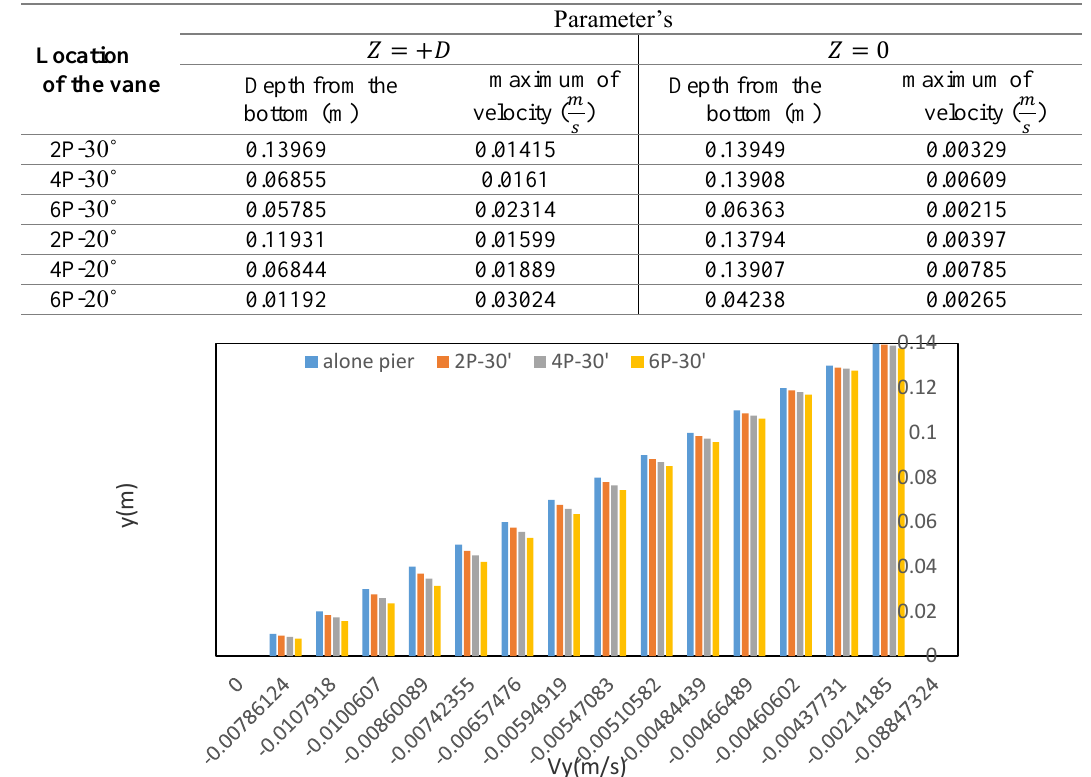
Table 6. The maximum values of vertical velocity component and depths of them respectively, at different angles and counts of vanes